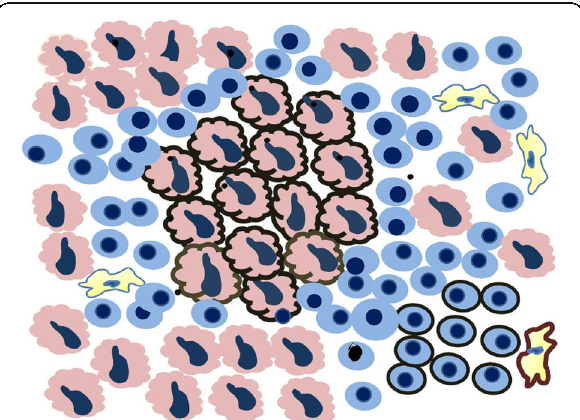
Fig. 9 Schematic drawing of a tumor with PD-L1 staining. There are 37 tumor cells, 14 of which are depicting membrane staining (middle part of the drawing). In addition, 10 of the tumor immune cells, including one macrophage, are positive for PD-L1 (lower right- hand corner). Based on this, tumor positive score (TPS) and combined positive score (CPS) can be